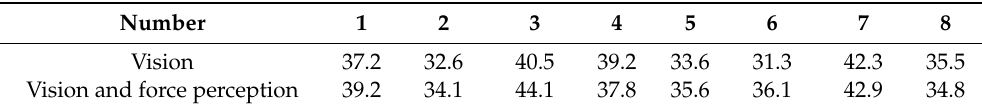
Table 2. Driving hours of visual and force interaction